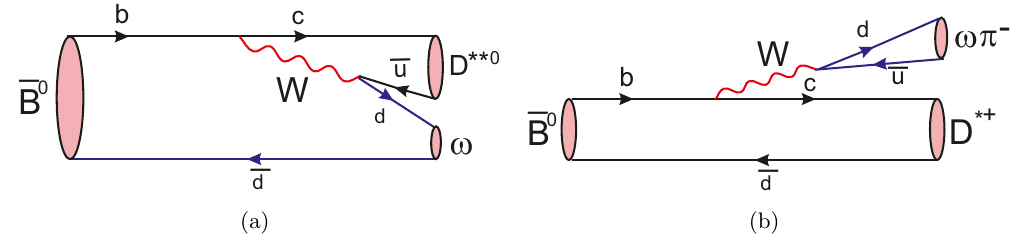
Figure 1 . (color online). (a) Color-suppressed and (b) color-favored quark diagrams taken from ref. [1] and showing D (cid:3)(cid:3) and !(cid:25) production in (cid:22) B 0 ! D (cid:3) + !(cid:25) (cid:0)